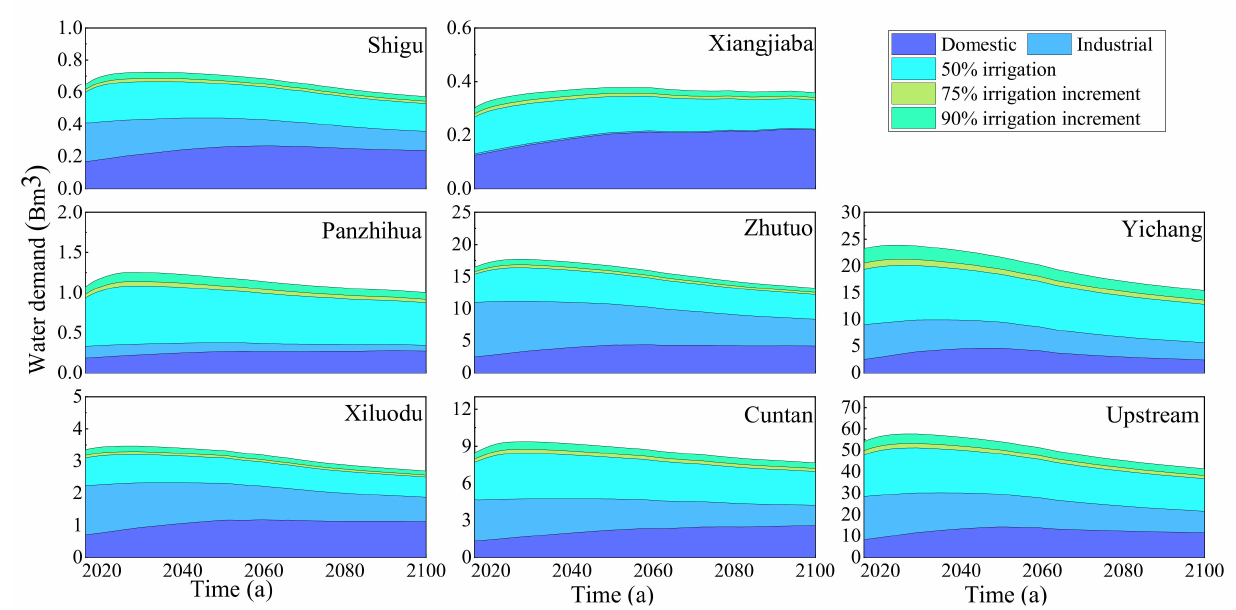
Figure 16. Forecasting of water demand in upstream Yangtze River and its